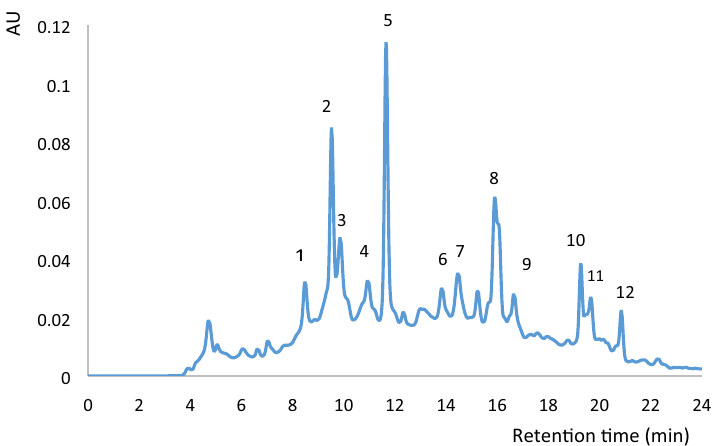
Figure 2. Reverse-phase high-performance liquid chromatogram obtained from the fraction < 3 kDa.